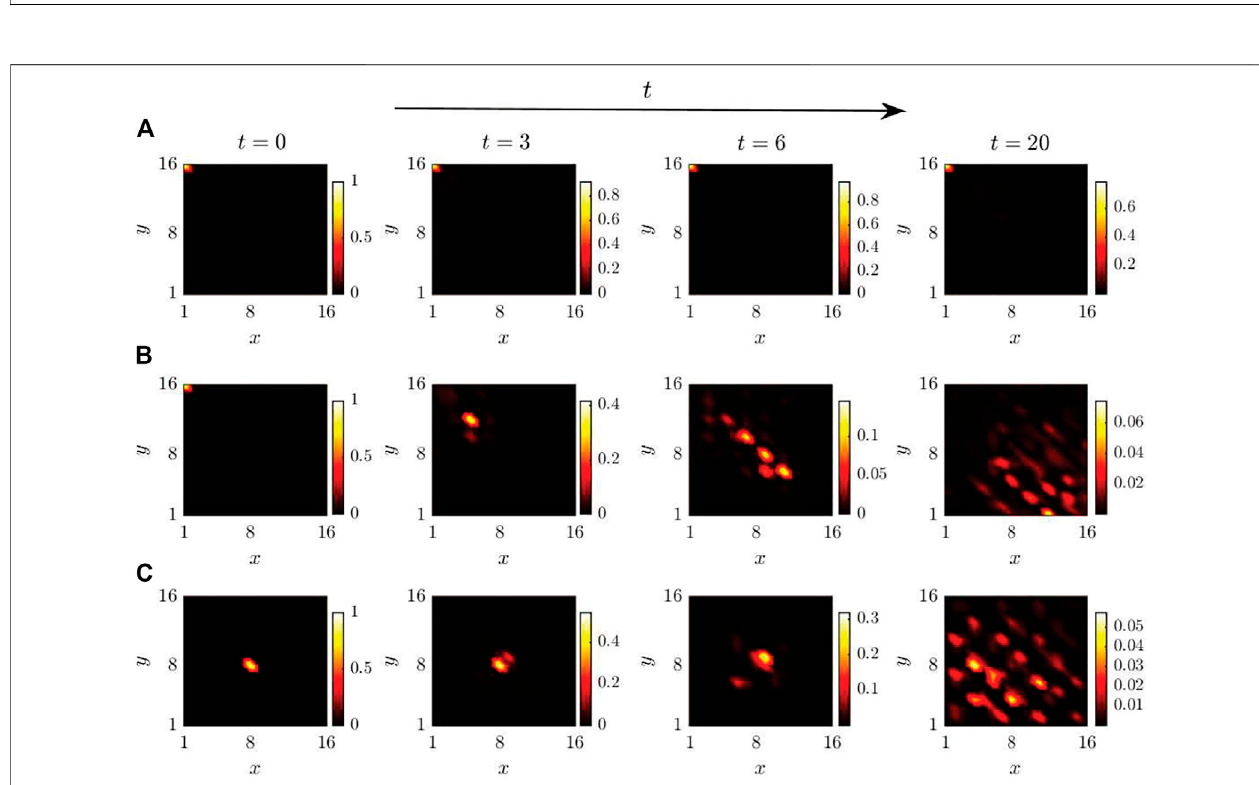
FIGURE6| Probabilitydistributions P ( x , y , t ) (cid:1) | 〈 x , y | ~ ψ ( t ) 〉 | 2 ofmulti-stepnon-unitarycoinlessDTQWsona16×16lattice.AftereachstepofthisDTQW,thestate of the walker | ψ ( t ) 〉 (cid:1) ^ U step | ~ ψ ( t − 1 ) 〉 will be normalized as | ~ ψ ( t ) 〉 with 〈 ~ ψ ( t )| ~ ψ ( t ) 〉 (cid:1) 1. The walker is initialized at the upper-left corner ( x , y ) = (1, 16) (A,B) or bulk ( x , y ) = (8, 8) (C) ofthe lattice. The gain-loss parameter is chosen as γ = 3.5 (A,C) or γ = 0.5 (B) , which correspond tothe topological or trivial phase, respectively.The steps are chosen as t = 0, 3, 6, 20. Here the coupling parameter is fi xed at J 1 = 1.1.